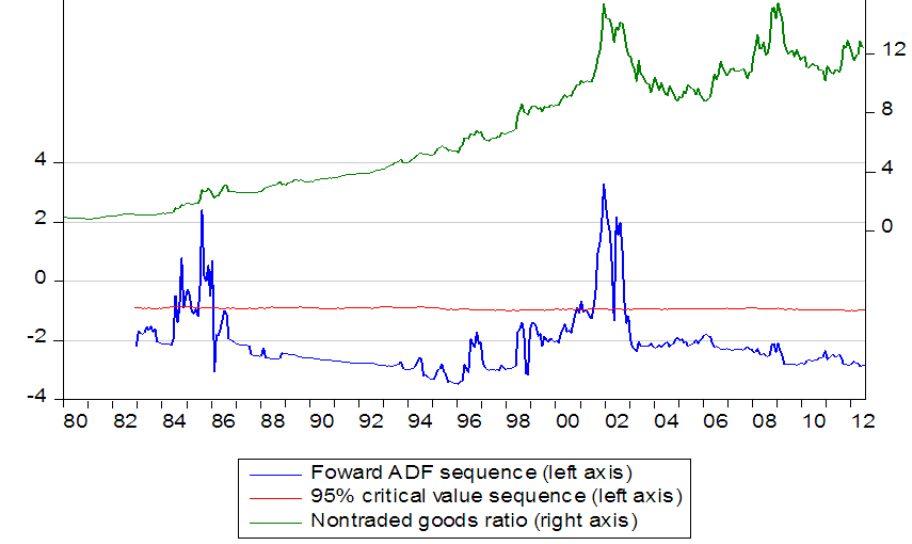
Fig. 2. SADF test for real exchange rate of non-traded